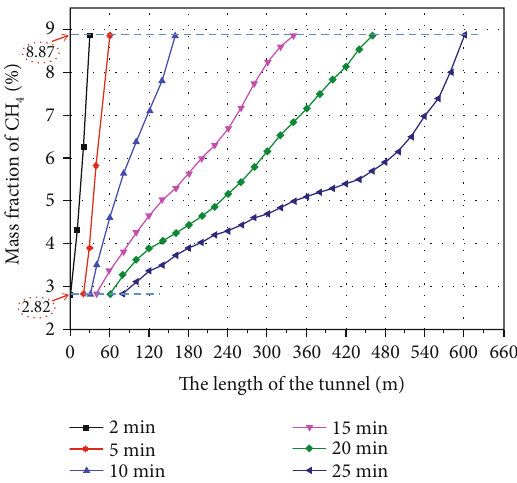
Figure 13: CH explosion cloud distribution in the tunnel (Case 4